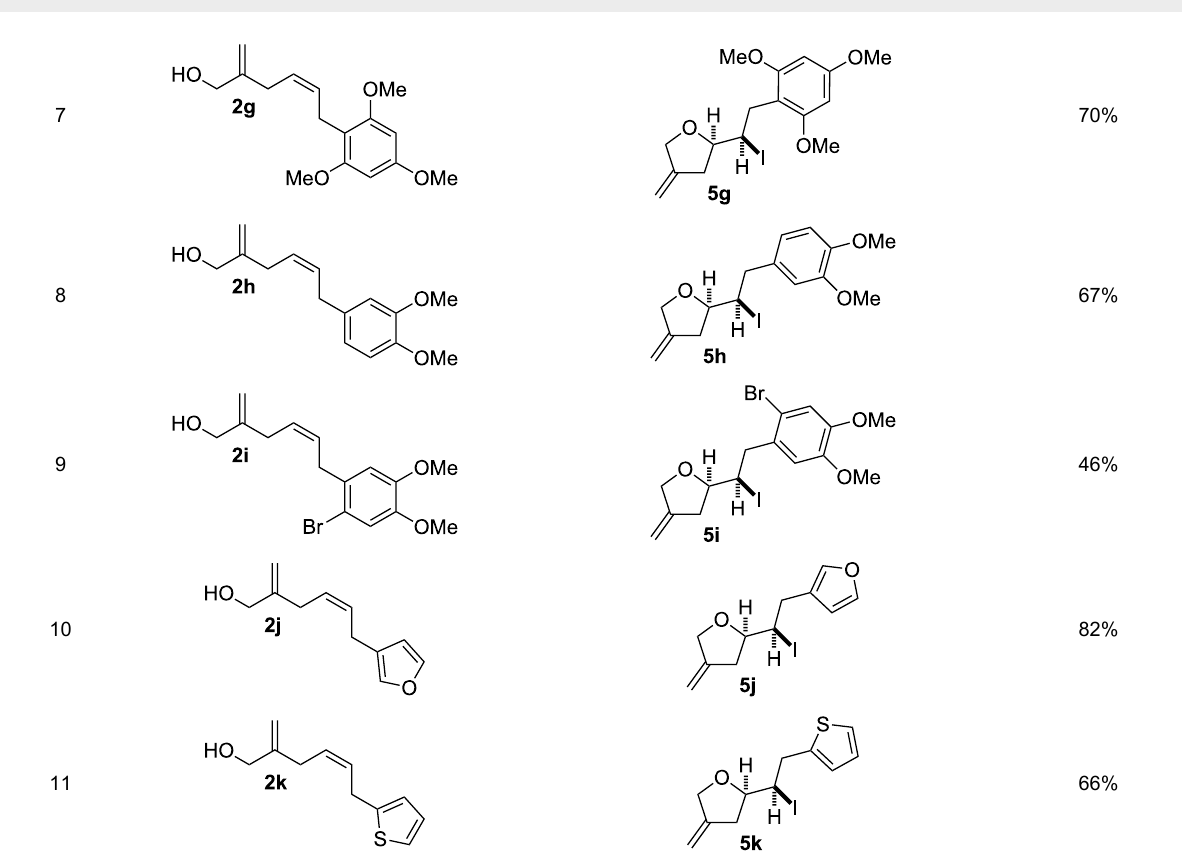
Table 3: Electrochemical iodoalkoxylation of 1,4-dienols 2 .